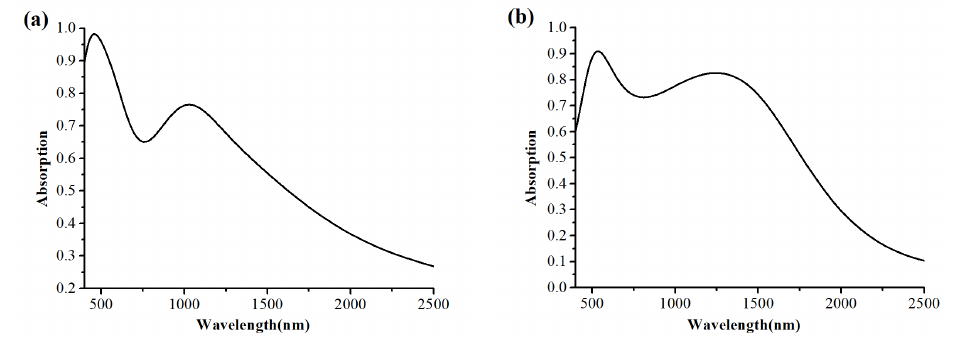
Figure 5. The absorption spectra of the proposed absorber: ( a ) tungsten nanosphere array is absent; ( b ) Mxene layer is absent.